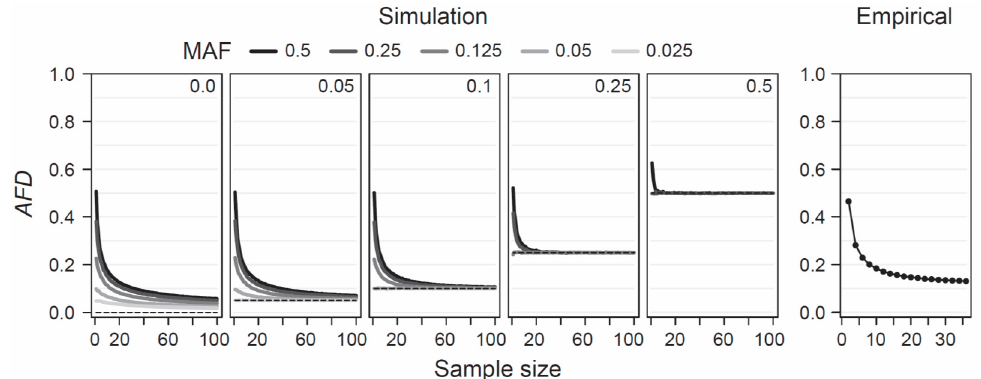
Figure 4. Sample size for AFD . Sensitivity of AFD to the size of the sample (number of nucleotides) taken from each population, explored by simulation (left) and using empirical population data (right). The simulations consider five di ff erent magnitudes of population di ff erentiation (the true parametric di ff erentiation is printed, and plotted as dashed line, inside each box), and up to five di ff erent MAF levels for each magnitude of di ff erentiation (indicated by the gray shades of the lines). Note that with increasing di ff erentiation, the possible MAF range becomes increasingly constrained. The lines show mean AFD across 10,000 replicate simulations for each sample size level. The empirical analysis shows mean AFD across the genome-wide SNPs from the lake-stream stickleback comparison shown in Figure 3b.